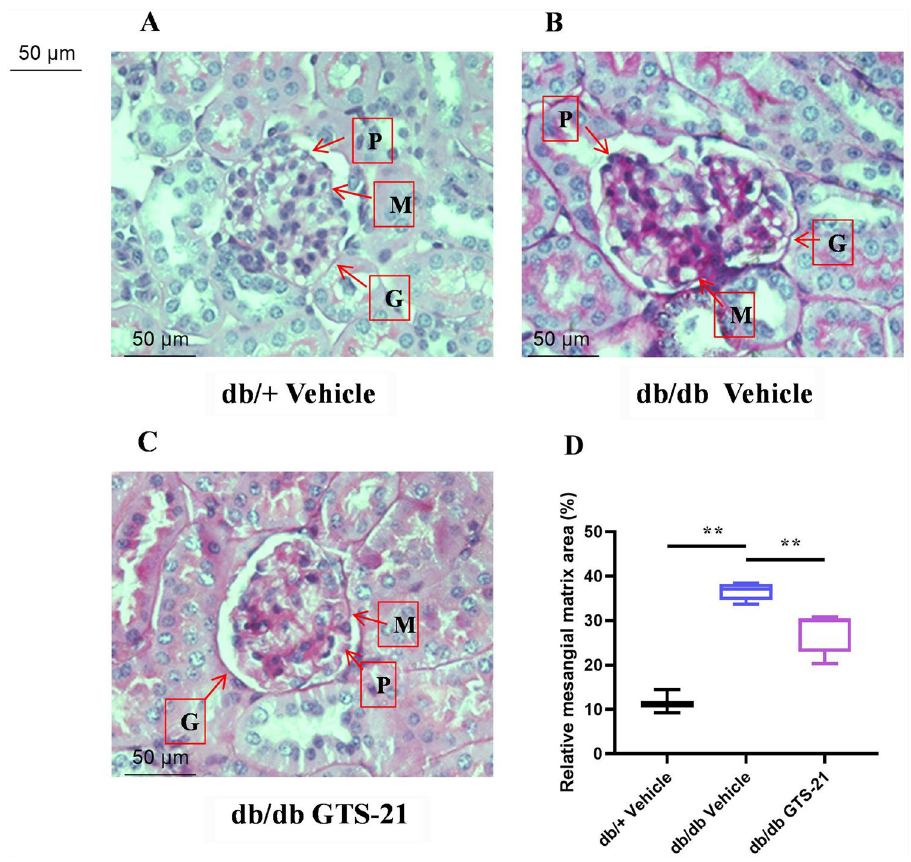
Figure 3. Histological assessment of diabetic nephropathy. All mice were treated with GTS-21 (4 mg/kg, IP, B.I.D.) or vehicle for 8 weeks. Kidney sections were stained with PAS to assess the glomeruli, mesangial matrix and basement membranes. Representative histological sections of the kidney are shown from db/+ mice ( A ), db/db mice ( B ) and db/db mice with GTS-21 ( C ). Magnification 400 ×. Histological changes in diabetic nephropathy were characterized by loss of podocytes (P), mesangial matrix expansion (M) and thickening of the glomerular basement membrane (G). Quantification of mesangial expansion was performed as described in Methods is shown in panel D . The data is represented as mean ± SE (n = 3–5/group), * P < 0.05, ** P <